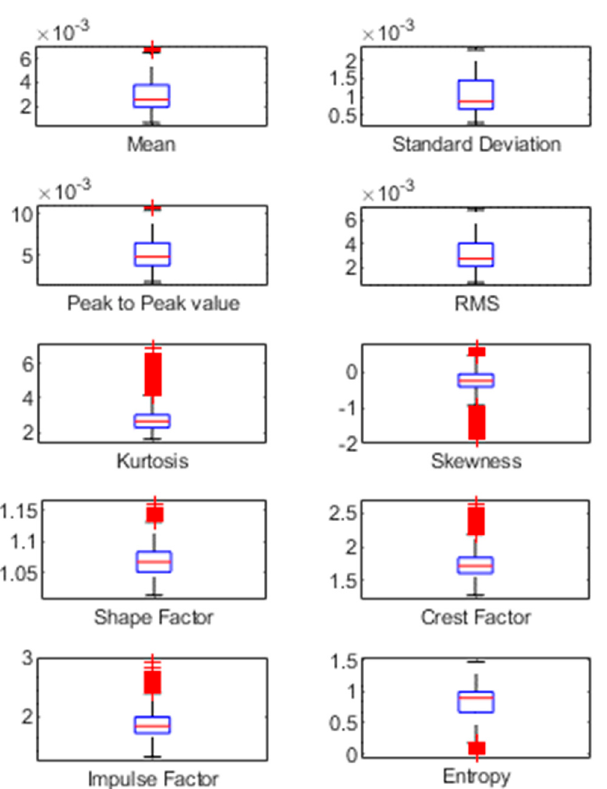
Figure 4. Boxplots to check similarity between all